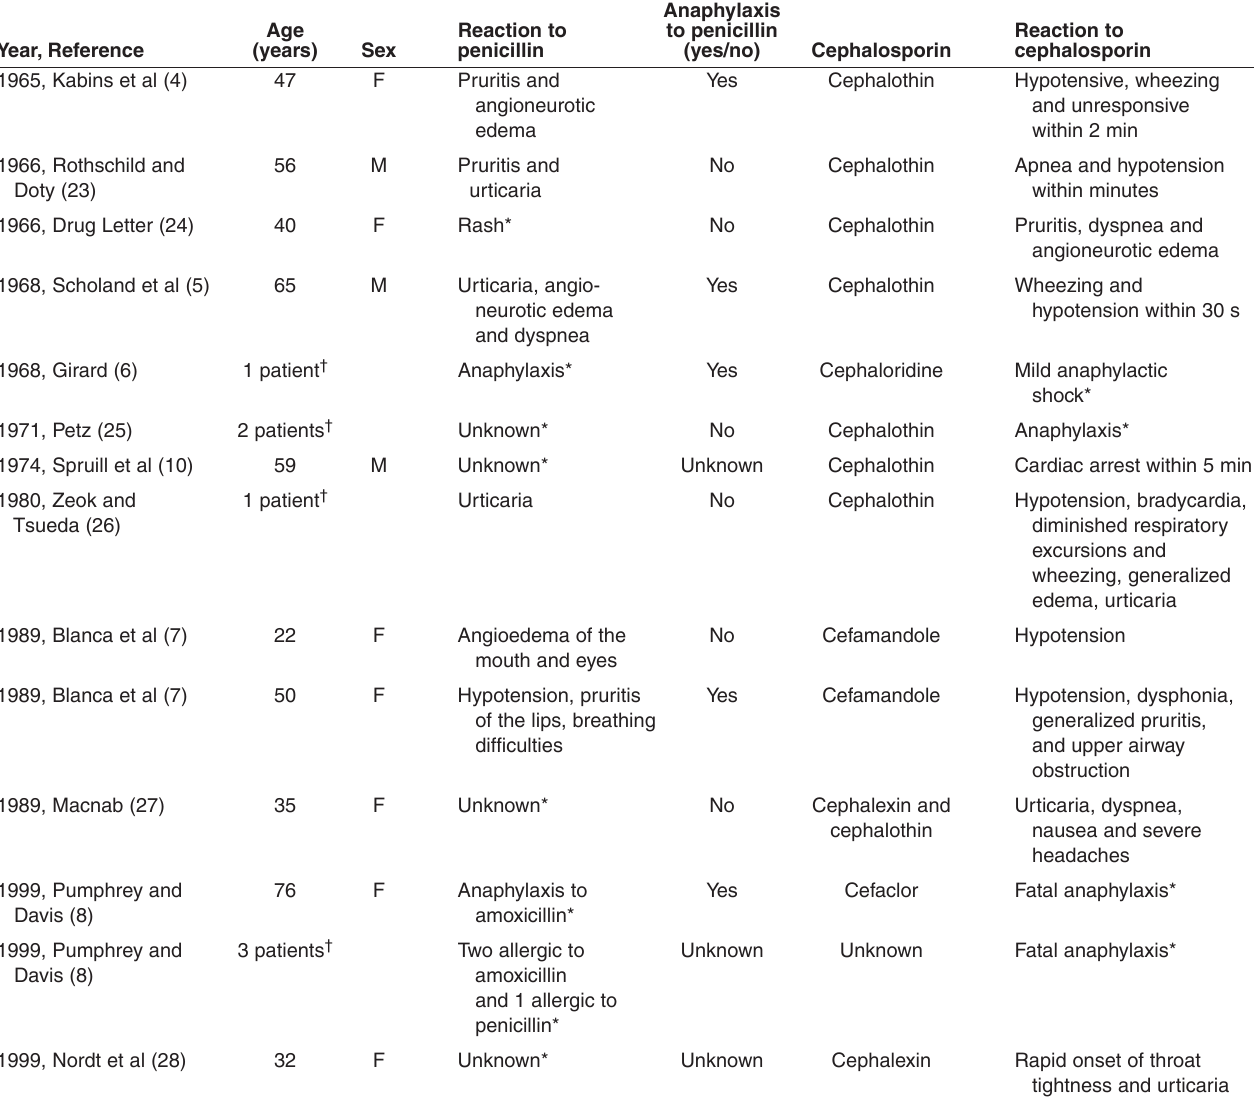
TABLE 1 Summary of case reports of anaphylaxis to cephalosporins in patients with a history of penicillin allergy or a positive penicillin skin